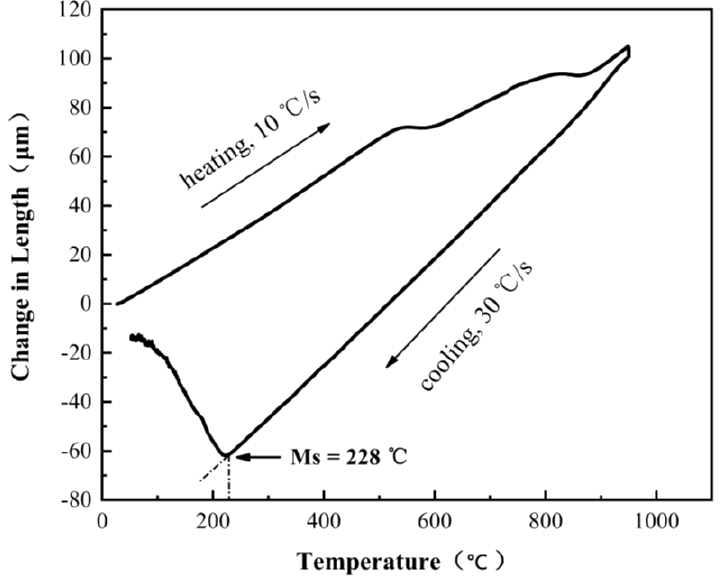
Figure 1. The dilatation curve of experimental steel.